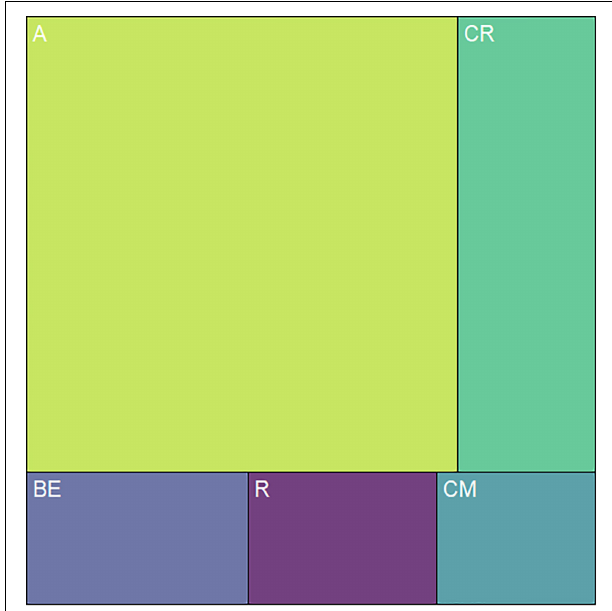
FIGURE 6 | Distribution of the 80 sampled species among the types of UV features. The relative area occupied by each quadrilateral polygon corresponds to the relative occurrence of each floral UV category. From the sampled species, 7.5% presented flowers that belonged to the (R) category and 58.7% to the (A) category, which indicates that 66.2% of species were non-UV-patterned. The remaining 33.8% of species presented UV floral patterns, being that 8.75% presented (BE) pattern, 6.25% presented (CM) pattern and 18.75%, (CR) pattern. R, non-patterned UV-reflecting; A, non-patterned UV-absorbing; BE, bullseye; CM, contrasting corolla markings oriented towards floral resources; CR, contrasting reproductive